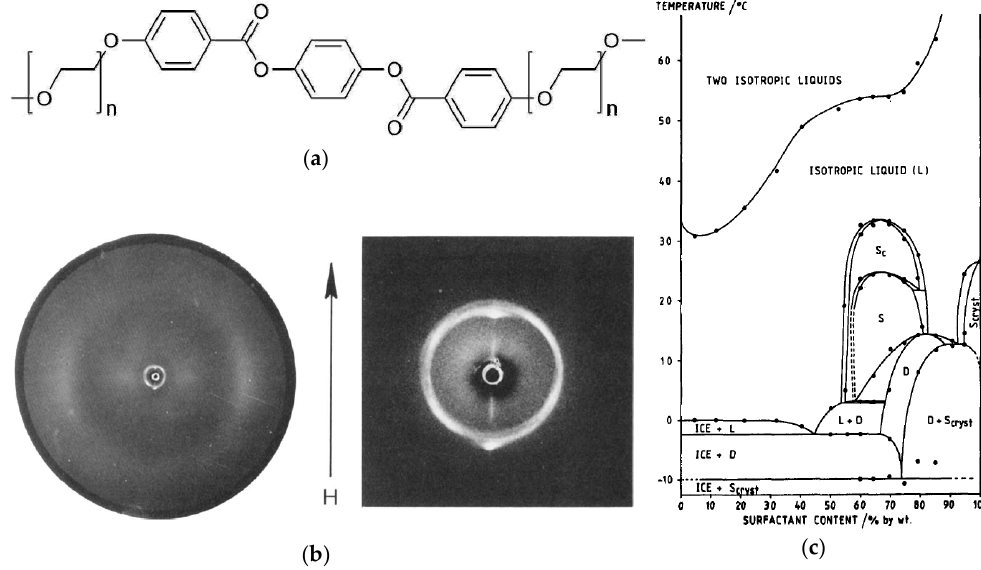
Figure 9. ( a ) A rigid aromatic core is combined with two polyethylene glycol units on each end, varying from n = 5 to n = 7. ( b ) Two-dimensional X-ray diffraction pattern of a magnetic-field aligned sample with 70 wt% percent of the amphiphile with n = 6 at 26 °C. The arrow indicates the direction of the magnetic field (H). The phase diagram corresponding to this system is shown in ( c ). The lyotropic SmC phase is denoted as ‘S C ’ in this diagram; ‘S’ and ‘D’ stand either for a supposedly higher ordered smectic or dystetic (i.e., L α ) phase, respectively. (Reprinted by permission form Taylor and Francis Ltd.: [25].)